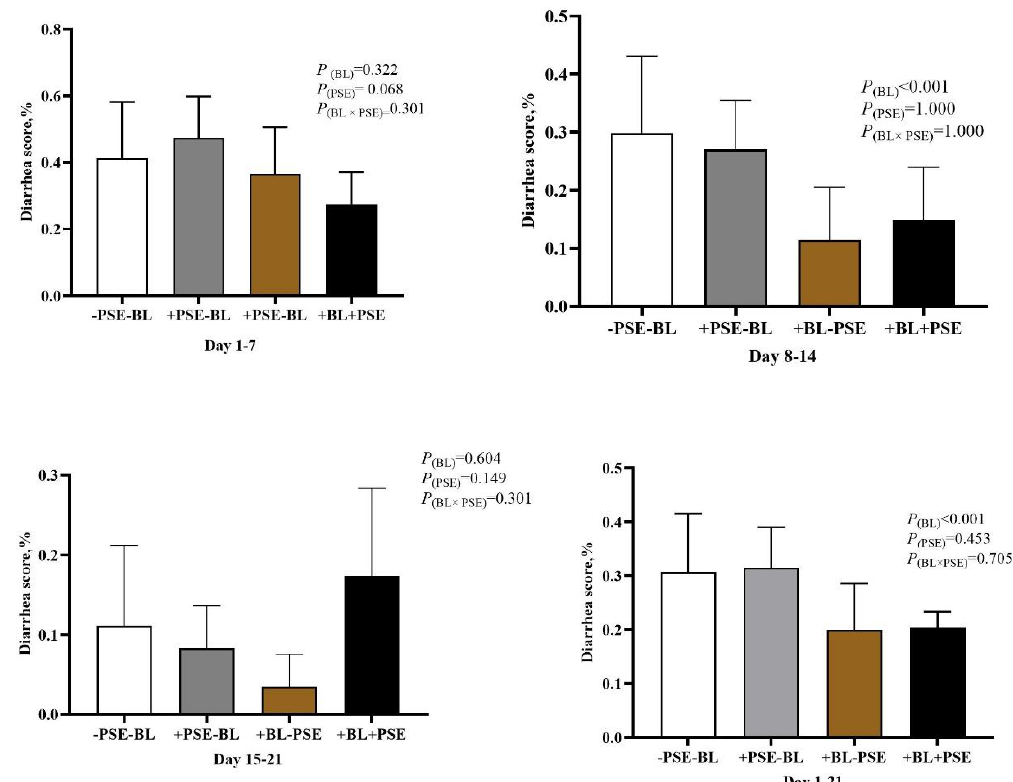
Figure 1. Effect of BL and PSE on the diarrhea rate of weaned piglets. Values are presented as means, n = 6. BL, multi-strain probiotics; PSE, Perilla frutescens seed extract; − PSE − BL, basal diet; +PSE − BL, basal diet + 1 g/kg Perilla frutescens seed extract; +BL − PSE, basal diet + 2 g/kg multi-strain probiotics; +BL + PSE, basal diet+2 g/kg multi-strain probiotics + 1 g/kg Perilla frutescens seed Table 3. Effects of BL and PSE on microbes in the ileal digesta of weaned piglets (10 copies/g of wet digesta) 1 .